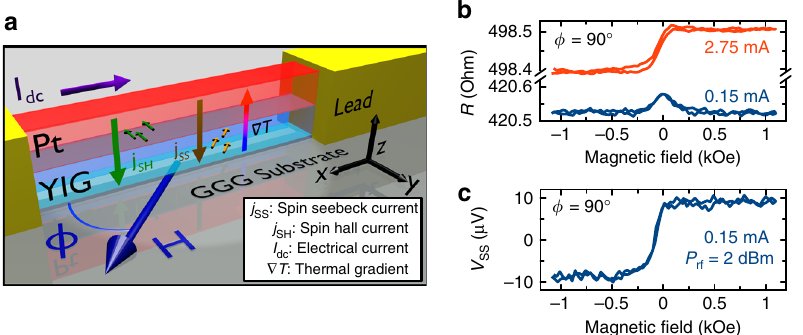
Fig. 1 YIG/Pt nanowire magnetoresistance. a Sketch of the YIG/Pt nanowire spin torque oscillator. Arrows across the YIG/Pt interface illustrate the fl ow of spin Hall j SH and spin Seebeck j SS currents with corresponding smaller arrows representing the spin current polarization. The directions of the temperature gradient ∇ T perpendicular to the YIG/Pt interface, the direct current I dc , and the magnetic fi eld H are depicted by arrows. b Magnetoresistance R of the YIG/Pt nanowire measured at low ( I dc = 0.15 mA) and high ( I dc = 2.75 mA) direct current bias for a magnetic fi eld applied in the sample plane at the fi eld angle ϕ = 90° with respect to the wire axis. c Spin Seebeck voltage V SS induced in the nanowire by a large microwave current (microwave power P rf = 2 dBm) as a function of magnetic fi